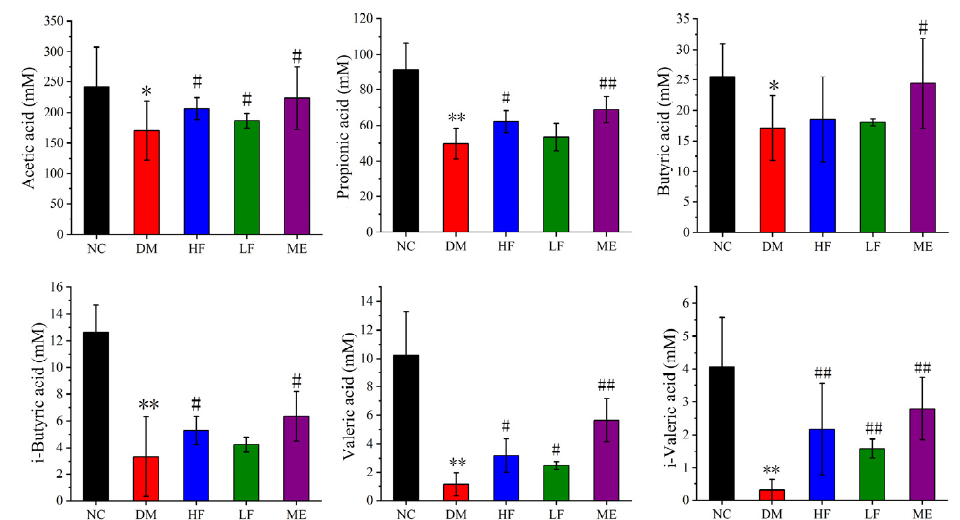
Figure 5. Effect of LJF on the SCFAs production, including acetic acid, propionic acid, butyric acid, i-butyric acid, valeric acid, and i-valeric acid. * p < 0.05 and ** p < 0.01 vs. NC group, and # p < 0.05 and ## p < 0.01 vs. DM group.